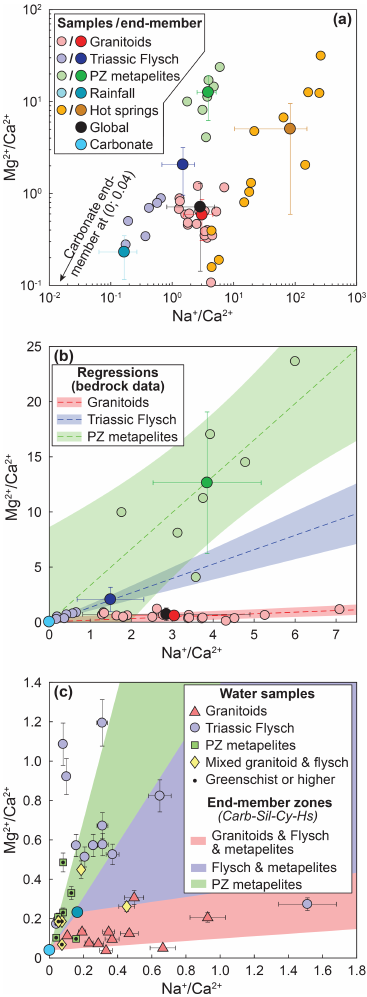
Figure 3. End-members and mixing lines in Na + / Ca 2 + – Mg 2 + / Ca 2 + space. (a) Small points mark individual bedrock, rain- water, and hot spring chemistry (Table S3) (Jiang et al., 2018; Chen et al., 2007; Weller et al., 2013). Large points with error bars mark corresponding end-member estimates (Table 1). Silicate end- members for granitoids and Paleozoic metamorphics as well as for the rainfall end-members are estimated from a mean and standard deviation of individual data points. The flysch silicate end-member was derived from a regression through the bedrock data and esti- mates of the carbonate content in the bedrock flysch samples (see text). For hot springs, the end-member is the median and interquar- tile range. The carbonate end-member cannot be shown in loga- rithmic space. (b) Bedrock chemistry and end-members with re- gressions through the bedrock data. Colored circles without error bars are lithology data. Colored points with error bars mark the es- timate for the silicate end-member for each lithology. The light- blue point marks the carbonate end-member. (c) Individual wa- ter samples within the end-member space. Colored areas mark the space between the carbonate, silicate, precipitation, and hot spring end-members for each lithology. Note that spaces are overlapping. Catchments underlain by different lithologies are distinguished by symbols and color. Data points with a black dot are metamorphosed to greenschist facies or